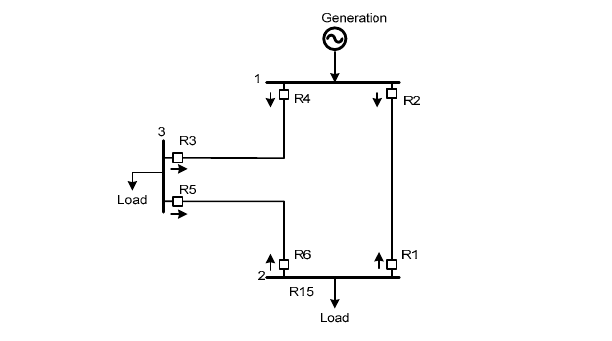
Figure 6. Single line diagram of the Institute of Electrical and Electronics Engineers (IEEE) 3-bus system. Table 1. Fault currents of primary and backup relays for IEEE 3-bus system understudy [13,35].